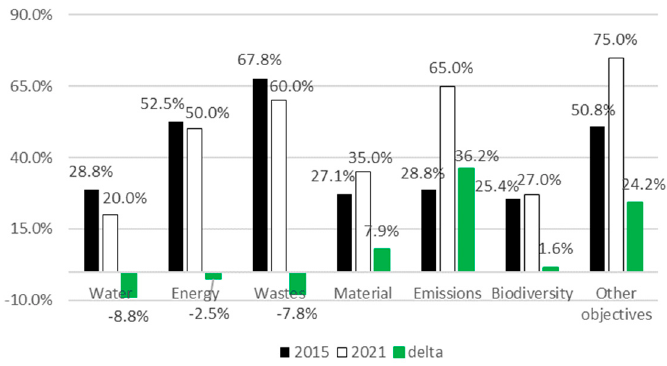
Figure 2. Organisations that set objectives in particular areas. Source: Reprinted from [19].